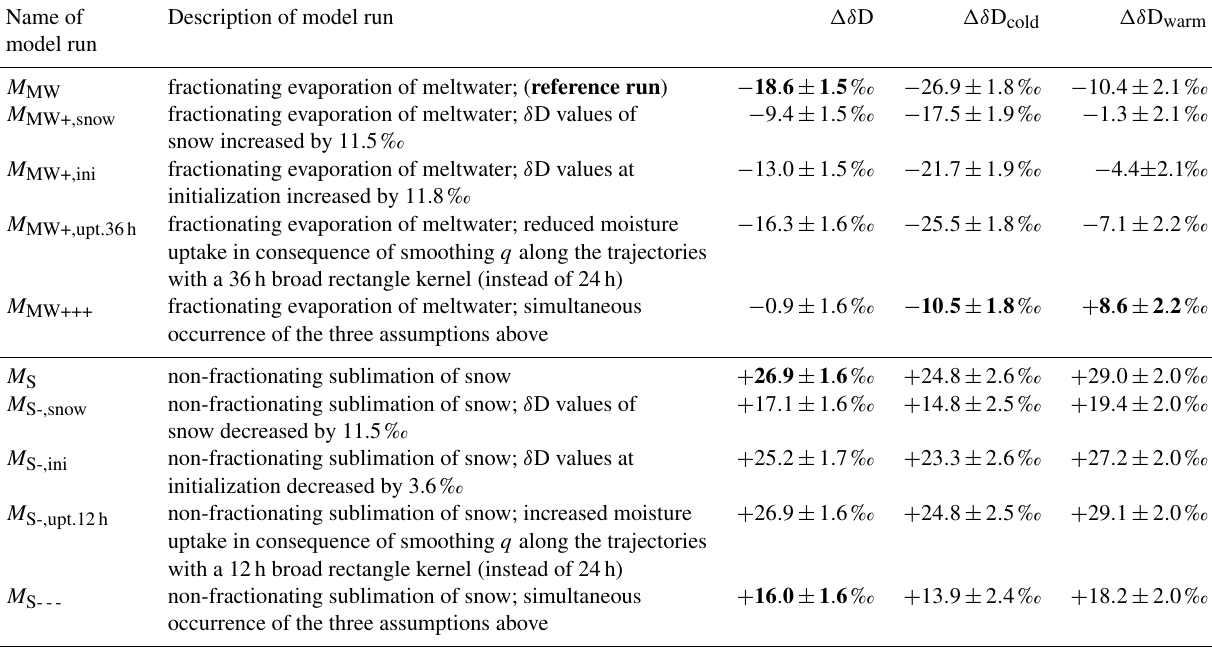
Table 1. Average differences between modeled and measured δ D of the 174 selected data points ( (cid:49)δ D), data points of group “cold” ( (cid:49)δ D cold ), and data points of group “warm” ( (cid:49)δ D warm ) from different model runs ( M ). ± states the statistical uncertainty of the aver- ages (root mean square error divided by the square root of the number of observations). Values of particular interest are printed in bold